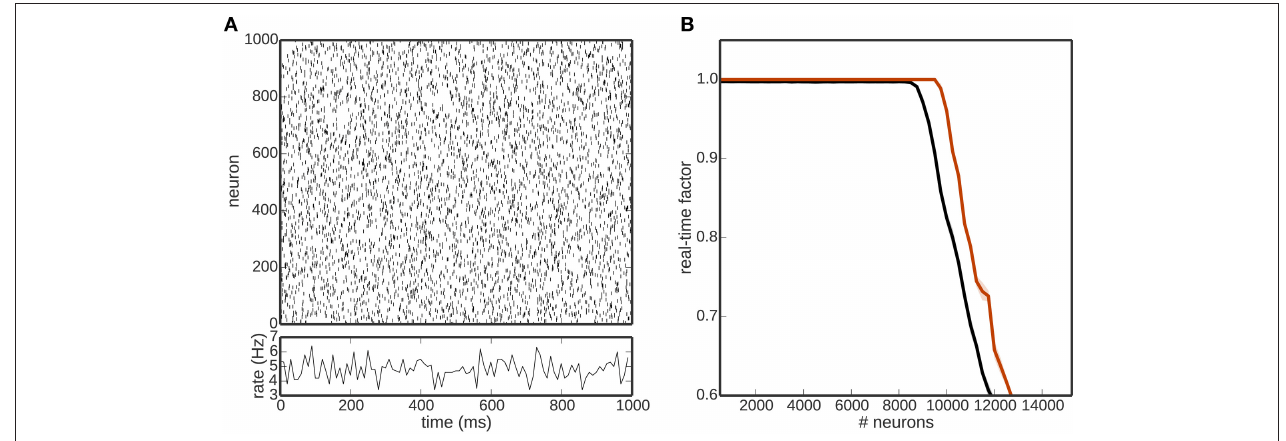
FIGURE 5 | (A) Network activity of one realization of the excitatory population of a balanced random network. (B) Real time factor as a function of the number of network neurons for a simulation purely in NEST (red) and incorporating the whole toolchain (black). Shaded areas denote the standard deviation over five